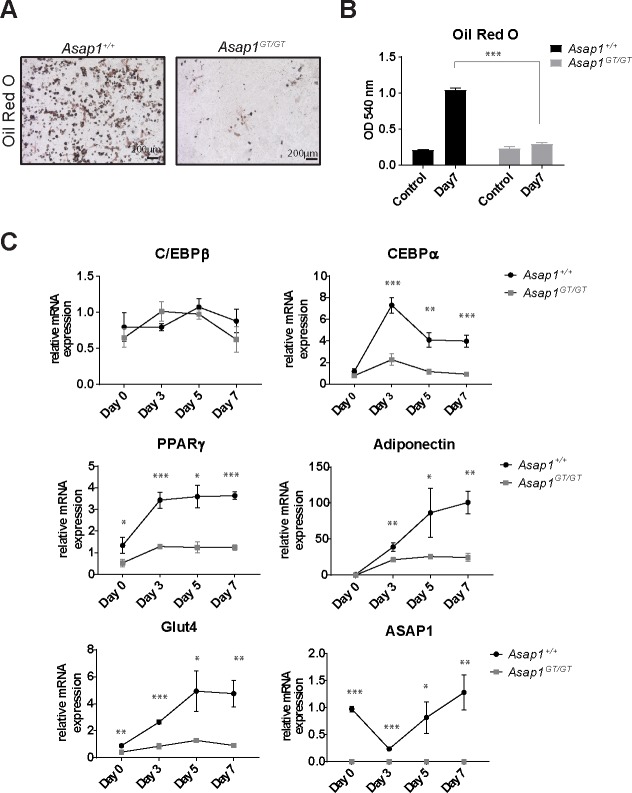
Loss of ASAP1 abrogates adipogenic differentiation in vitro.(A) Asap1+/+and Asap1GT/GT MEFs were induced to differentiate into the adipogenic lineage, and stained for Oil Red O. Representative images of uninduced controls and differentiated cells after 7 days are shown (upper panel). Scale bars: 200 μm. (B) Quantification of Oil Red O staining (lower panel). Oil Red O was extracted and the OD measured at 540 nm. The graph represents the mean ± SD of one representative experiment out of three performed, each of which was performed with three biological replicates. Significance was calculated using the Student’s t-test. *** p < 0.0005. (C) Adipogenic markers are not induced in differentiated ASAP1-deficient cells. qPCR analysis of differentiating MEFs at day 0, 3 and day 7. Relative mRNA expression was analyzed for C/EBPβ, C/EBPα, PPARγ, adiponectin, Glut4 and ASAP1, and normalized to expression of RibP0. Data represent the mean ± SD (Asap1+/+, n = 3 and Asap1GT/GT, n = 3). Significance was calculated using the Student’s t-test. *, p < 0.05, ** p < 0.005.